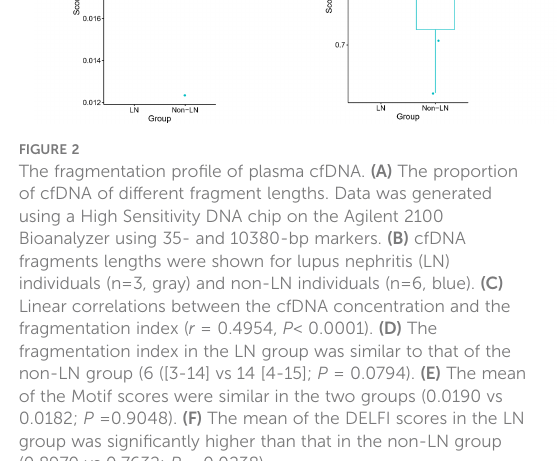
wasnocorrelationbetweencfDNAconcentrationandotherclinical indicators in LN patients, such as neutrophilic granulocyte percentage, C-reactive protein, erythrocyte sedimentation rate, albumin, serum creatinine, estimated glomerular fi ltration rate, urinary red blood cells, 24-h urinary protein, complement 3 or complement 4, immunoglobin, and SLEDAI score ( P > 0.05). cfDNA concentrations were also unaffected by treatment with cyclophosphamide or tacrolimus ( P > 0.05).